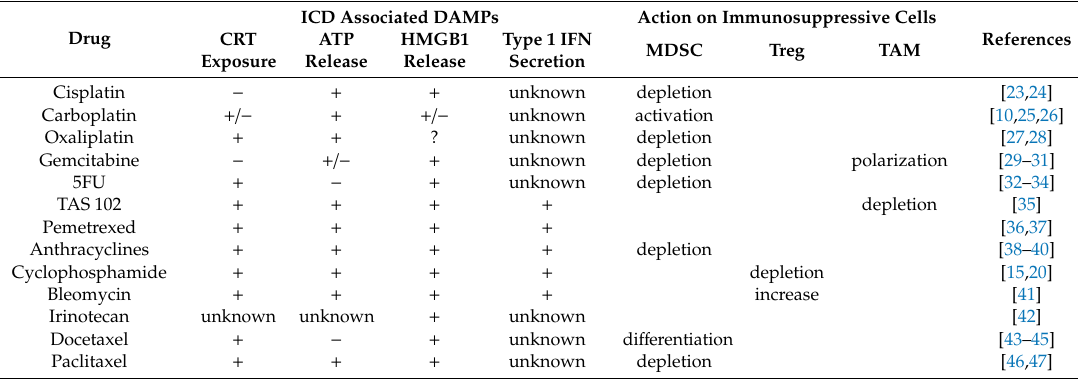
Table 1. ICD and depletion of immunosuppressive cells by chemotherapies.